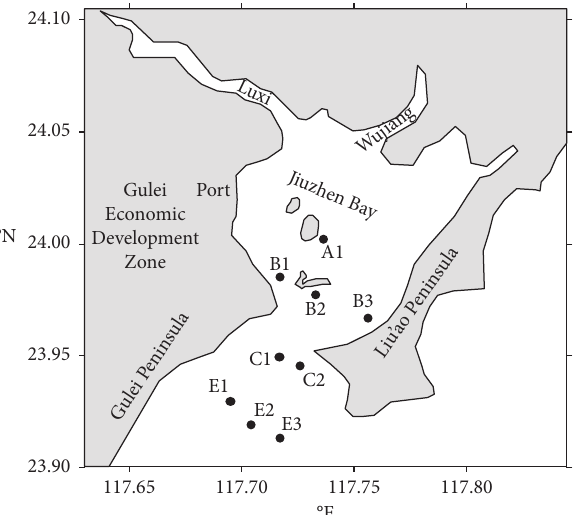
Figure 1: Location of the Jiuzhen Bay study area and all sampling